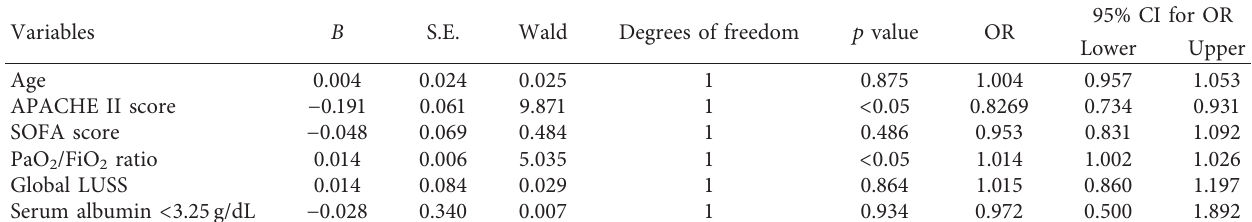
Table 6: Depiction of the multivariable logistic regression of the variables in the study to predict survival.